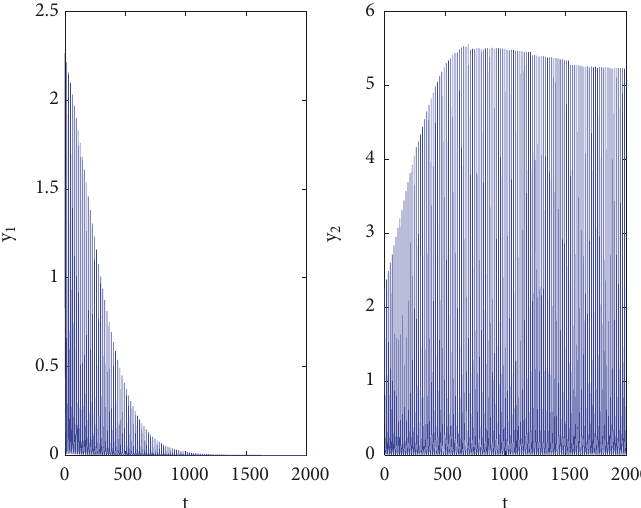
Figure 4: The simulated solutions of 𝐼 1 (𝑡) and 𝐼 2 (𝑡) under the condition 𝑟 = 1 , 𝑘 = 2 , 𝑏 1 = 0.8 , 𝑎 1 = 1.2 , 𝑑 1 = 0.5 , 𝑏 2 = 0.8 , 𝑎 2 = 1.2 , 𝑑 2 = 0.5 and 𝑐 1 = 0.02 , 𝑐 2 = 0.01